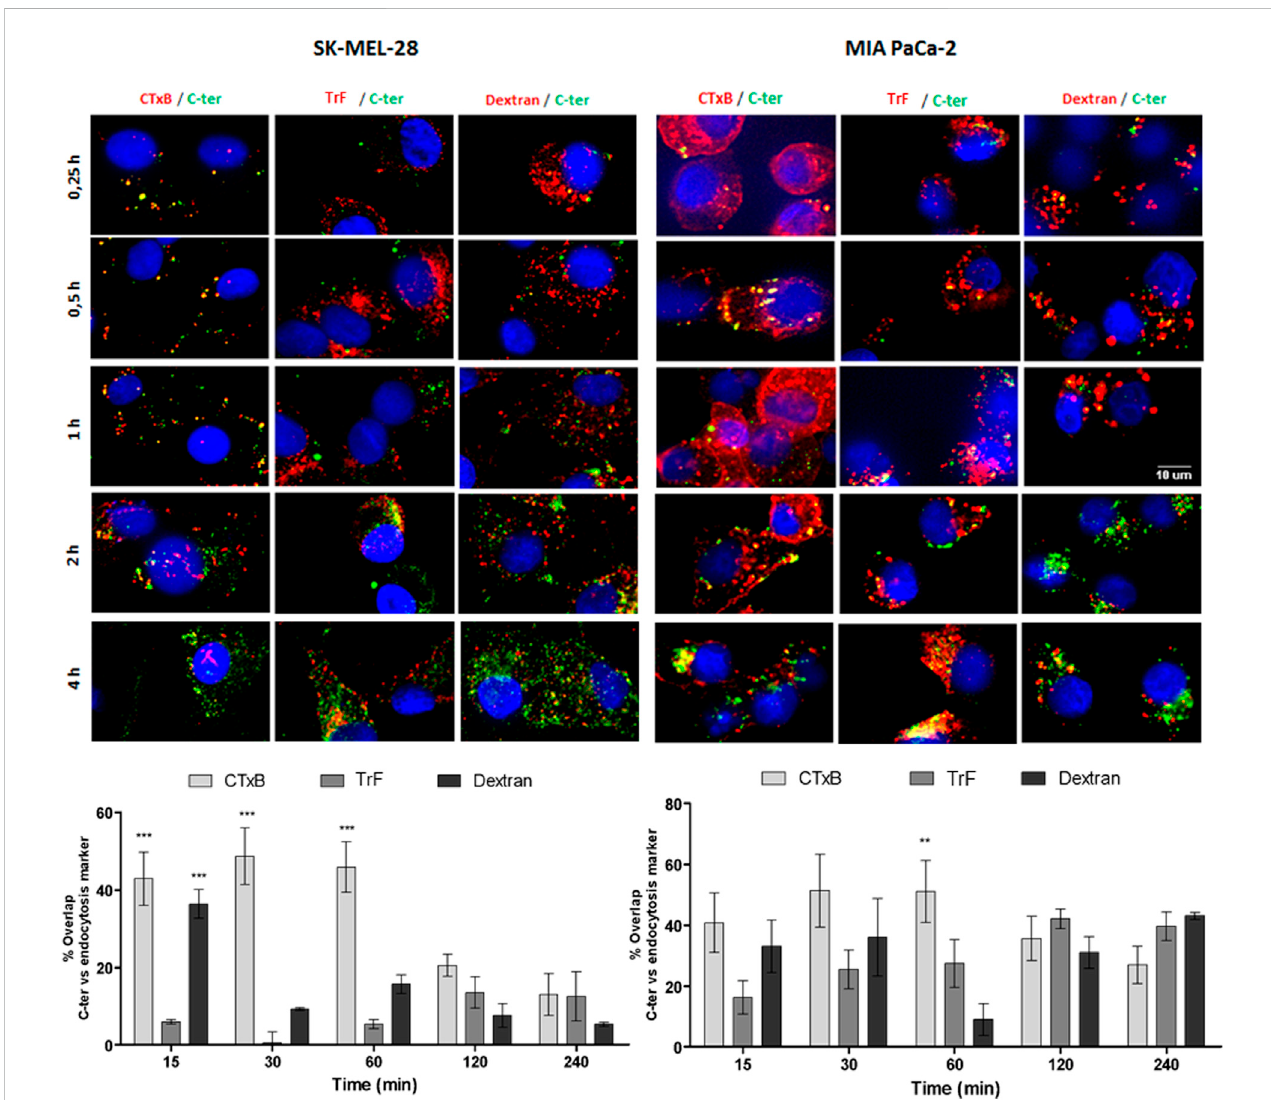
FIGURE 4 488-C-teruptakestartedbylipidrafts.Tumorcelllinesweretreatedwith488-C-terattheindicatedtimes;thenAlexaFluor555TrF(transferrin-100 μ g/ ml),AlexaFluor555choleratoxinsubunitB(CTxB-50 μ g/ml)orAlexaFluor555dextran(1 mg/ml)wereaddedinthebindingmediumat37 ° Cfor20 min.The nuclei were stained with Hoechst 33342. Next, automated images using ImageXpress Micro Confocal plate-scanning microscope (Molecular Device) at ×60 magni fi cation at three wavelengths (for FITC, Texas Red and DAPI) were taken for nine fi elds per well. Overlap was analyzed using MetaXpress software (Molecular Devices, Sunnyvale, CA). Values are mean ± SD of three independent experiments (each one carried out using nine fi elds per well and in triplicate). * p ≤ 0.05; ** p ≤ 0.01 and *** p ≤ 0.001 (comparing % of overlap between C-ter-488 and endocytosis markers at each time of